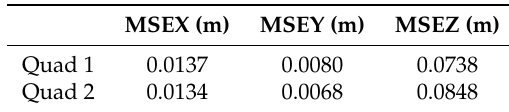
Table 8. Total Mean Squared Error in the estimated relative position of Quad 1 and Quad 2 with respect to the